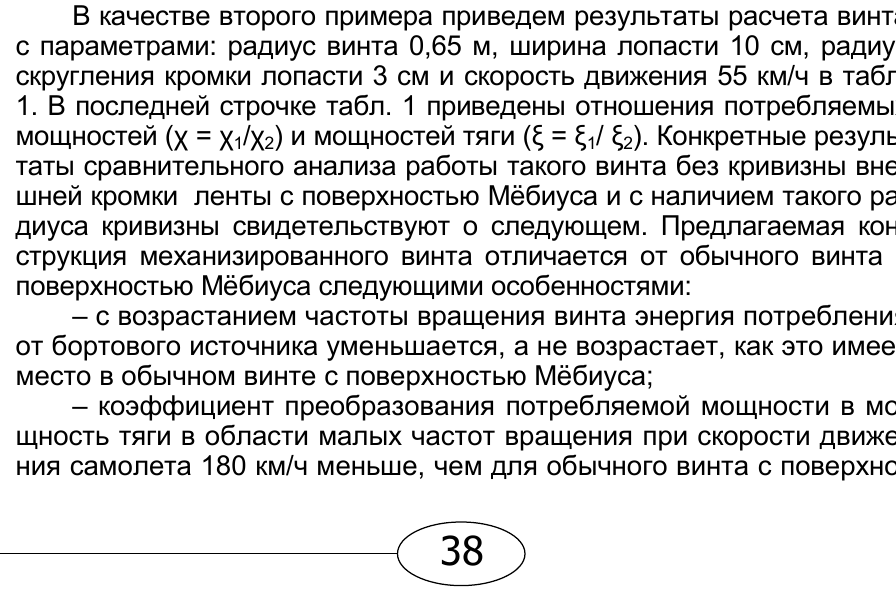
Figure 5 – Dependence of the power on the propeller rotation speed: 1- used power without mechanisation, 2- thrust power without mechanisation, 3- used power with mechanisation, 4- thrust power with